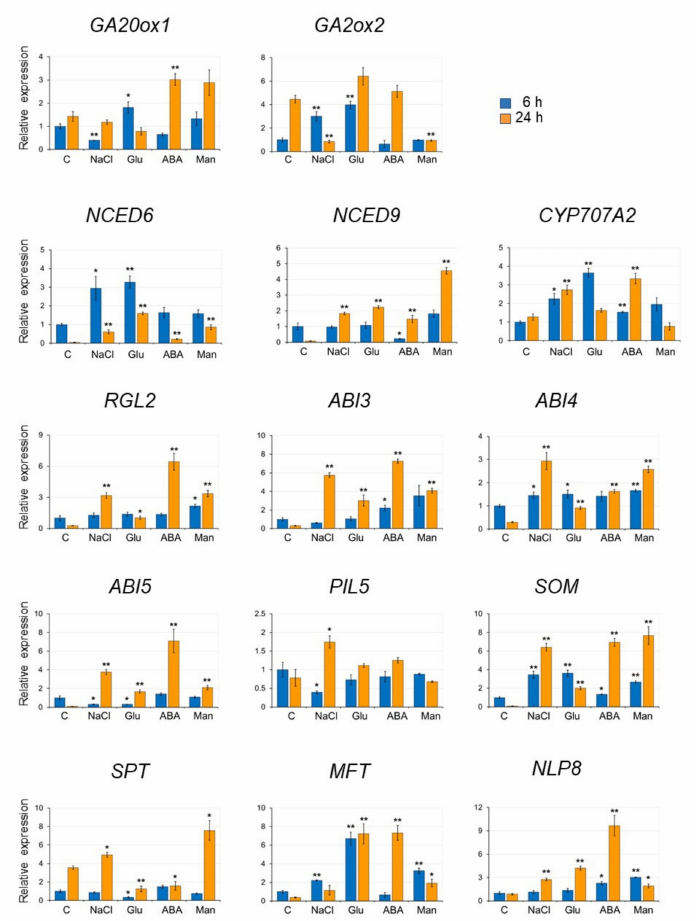
Figure 4. Expression of genes involved in the regulation of seed germination in the presence of NaCl, glucose, ABA, and mannitol. Seeds were imbibed in the presence of 170 mM NaCl, 278 mM glucose (Glu), 5 µ M ABA, and 500 mM mannitol (Man) for 6 h and 24 h. C: control (no inhibitory compounds). Gene expression was quantified by quantitative RT-PCR (qRT-PCR) and presented as relative to the levels in the control seeds (imbibed for 6 h). The expression levels were normalized against the expression of ELONGATION FACTOR1 α A4 ( EF1 α A4 ). Data are presented as the mean ± SD of three replicates. Asterisks indicate a significant di ff erence between control and each treatment at p < 0.01 ( ** ) and p < 0.05 ( * ). (Student’s